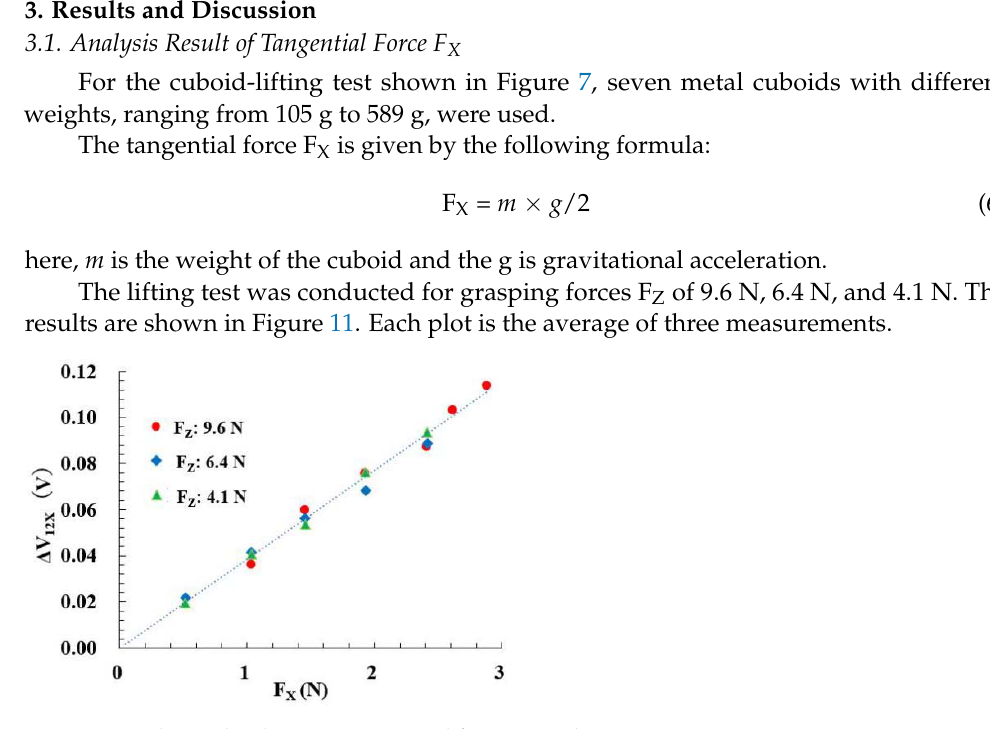
Figure 11. Relationship between tangential force F X and Δ V 12X .